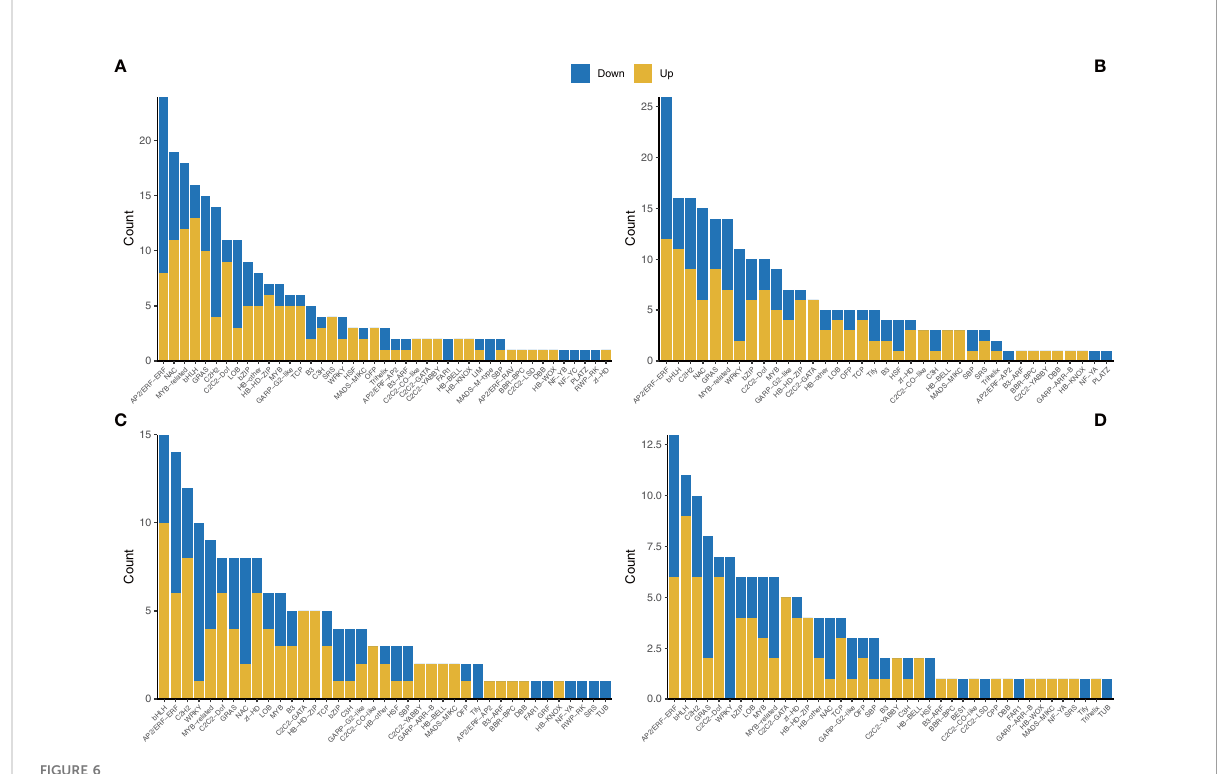
FIGURE 6 Transcription factor annotations of the unigenes of different comparisons. (A) NC vs AC. (B) NL vs AL. (C) NP vs AP. (D) NS vs